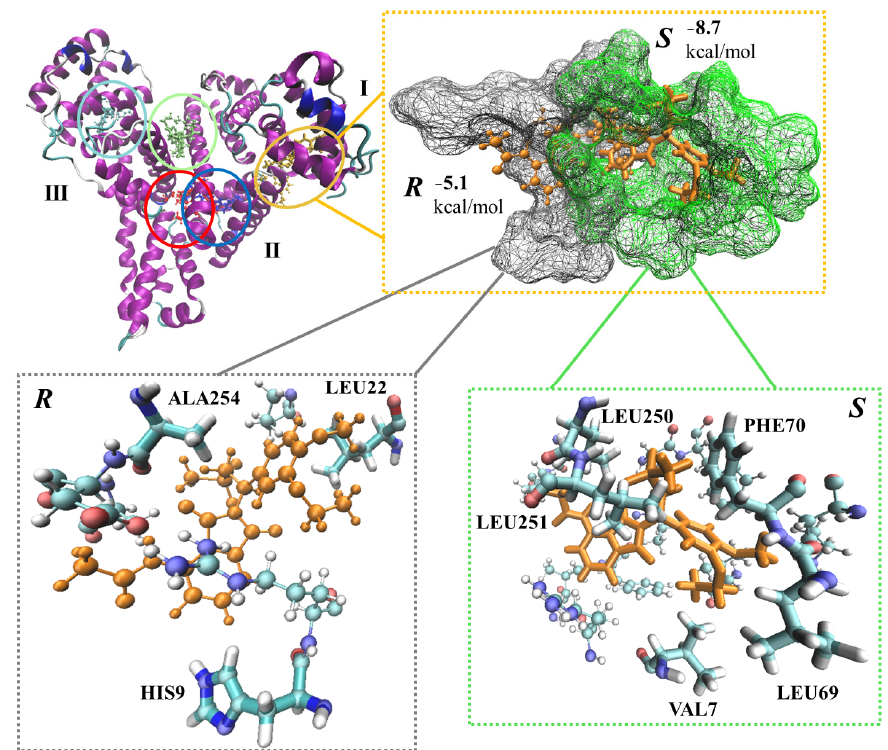
Figure 5. APR ( S ) and its enantiomer ( R ) docked to potential binding sites of human serum albumin (HSA, top left corner). I, II and III are HSA domains. The structures are highlighted in red, blue, lime, yellow and cyan. The most favored APR binding was selected along with the corresponding enantiomer (top right corner). Amino acid residues within 2 Å of the ligands are highlighted (bottom). The least and most favored binding of APR on HSA deviated by almost 5 kcal/mol in terms of docking scores (Table 4, Figure 5, lime and yellow, respectively). Table 4. Docking scores of APR at potential human serum albumin (HSA) binding sites. Docking Score of S -APR Docking Score of R -APR Structures at the Potential (kcal/mol) (kcal/mol) Binding Sites *